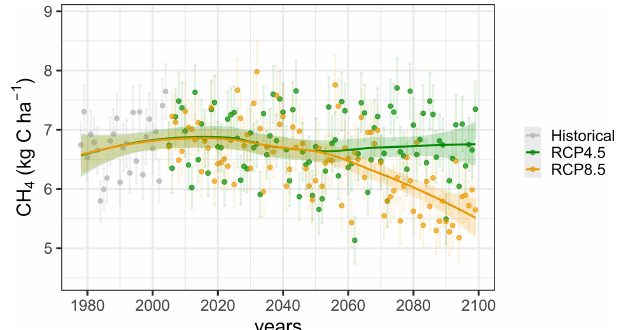
Figure 8. CH 4 emissions (kgC-CH 4 ha − 1 yr − 1 ) from enteric fer- mentation in grasslands with two climate change scenarios (RCP4.5 and